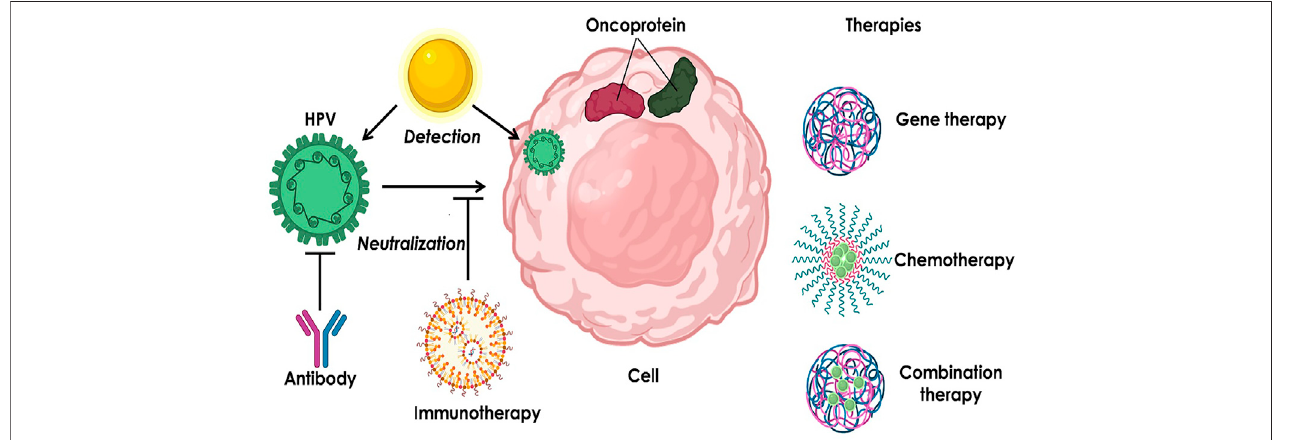
FIGURE 1 | Summary of the nanotechnology-based strategies for HPV infection-induced diseases.